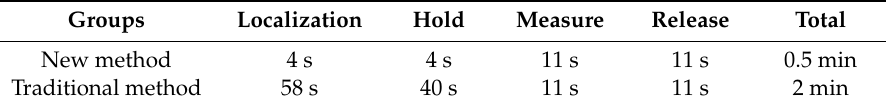
Table 2. Measuring speed comparison between traditional and new method.